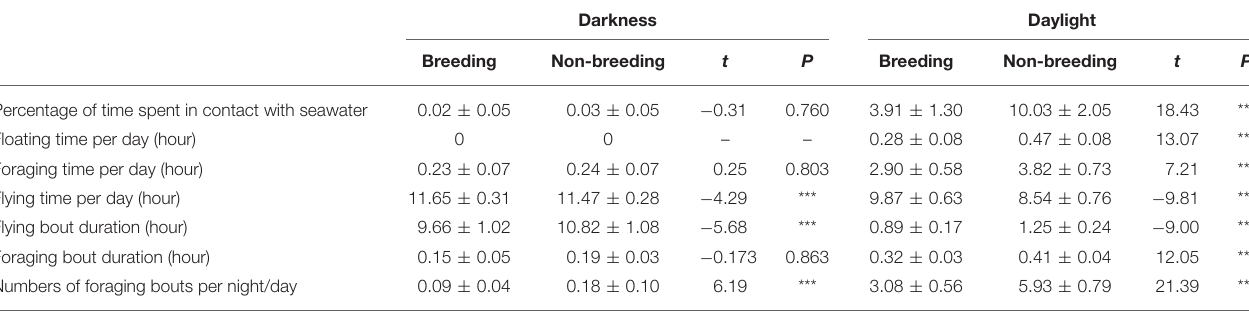
TABLE 3 | Comparisons between darkness and daylight activity parameter values (mean ± SD ) during the breeding and non-breeding seasons for sooty terns from Bird Island ( N = 36). Darkness Daylight Breeding Non-breeding t P Breeding